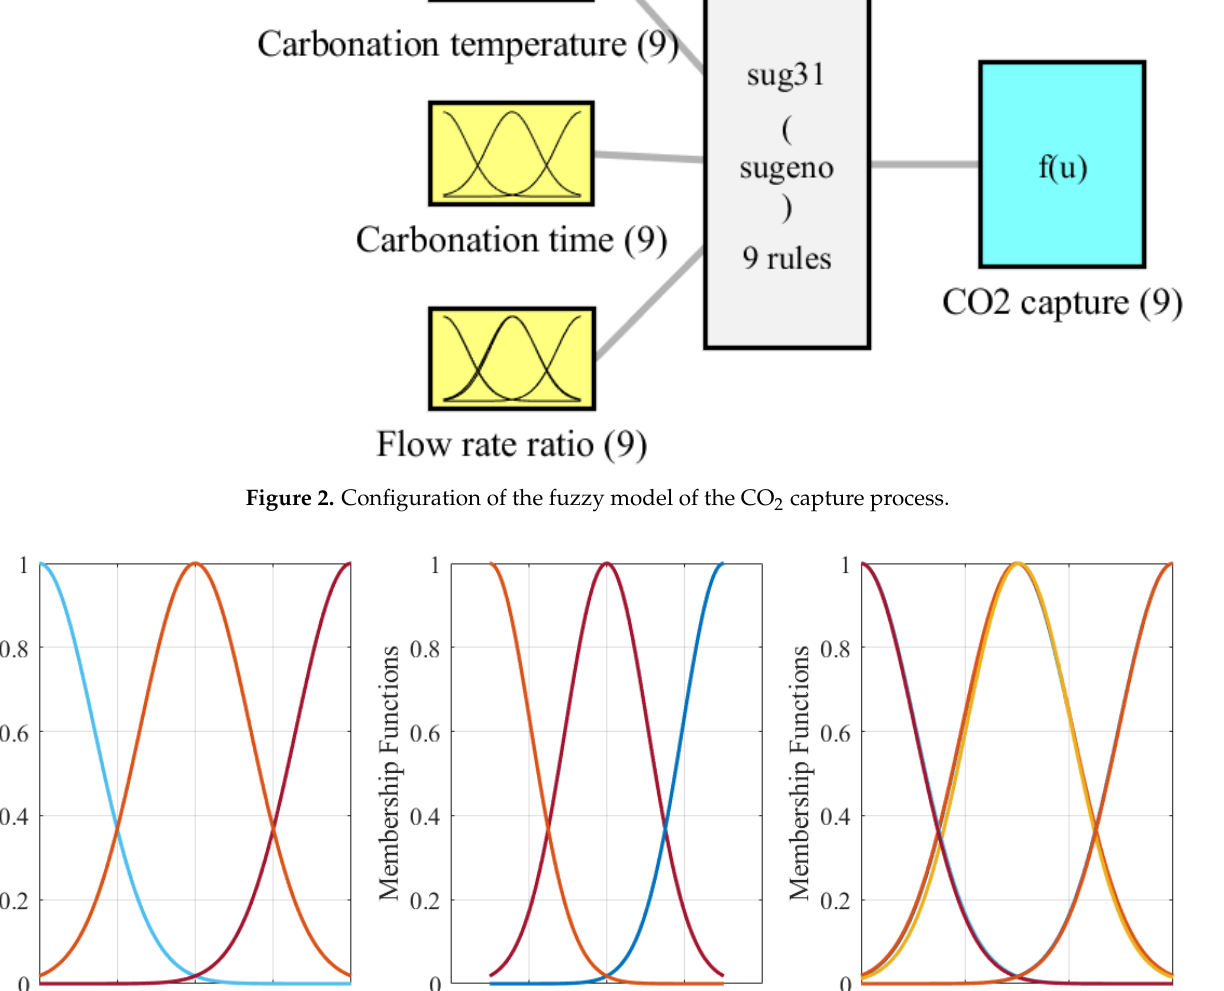
Figure 3. Membership functions of the fuzzy model of the CO 2 capture process.